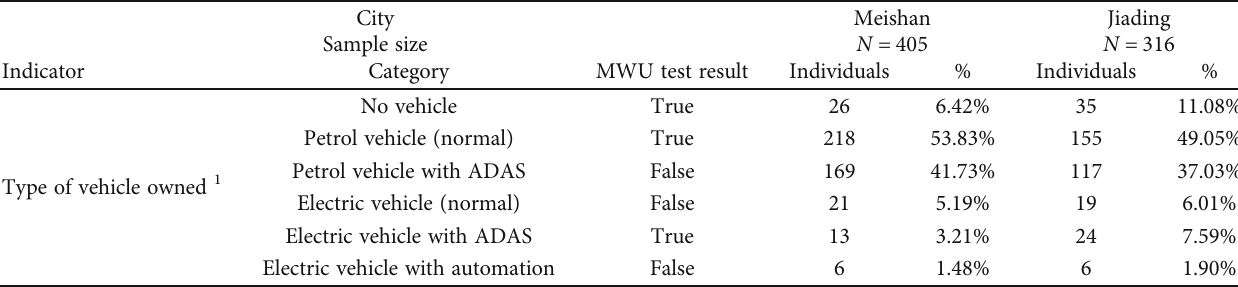
Table 2: Type of vehicle owned characteristic of the sample in the two cities.